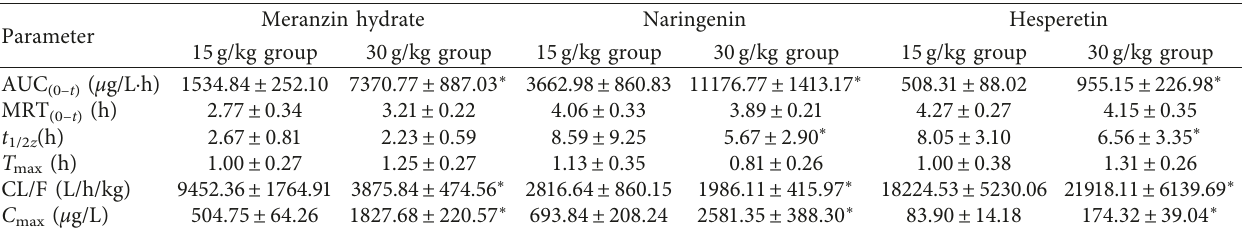
Figure 4: The mean ( ± SD, n � 8) plasma concentration-time profiles for meranzin hydrate (a), naringenin (b), and hesperidin (c) following oral administration of FA decoction at doses of 15g/kg and 30g/kg. Table 5: Pharmacokinetic parameters for meranzin hydrate, naringenin, and hesperetin in rat plasma after oral administration of FA decoction at doses of 15g/kg and 30g/kg ( n �